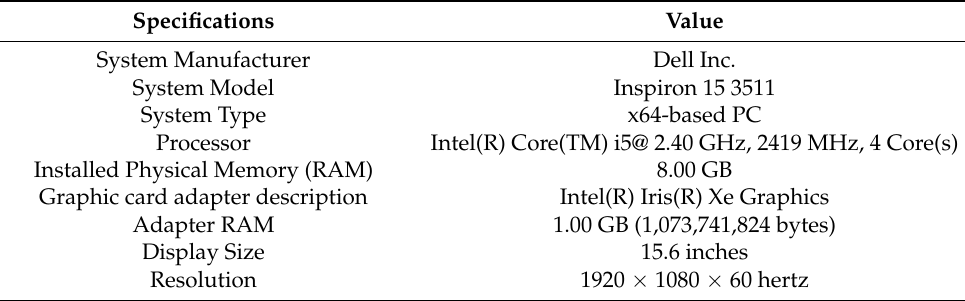
Table 5. Dell Inspiron 15 3000 laptop